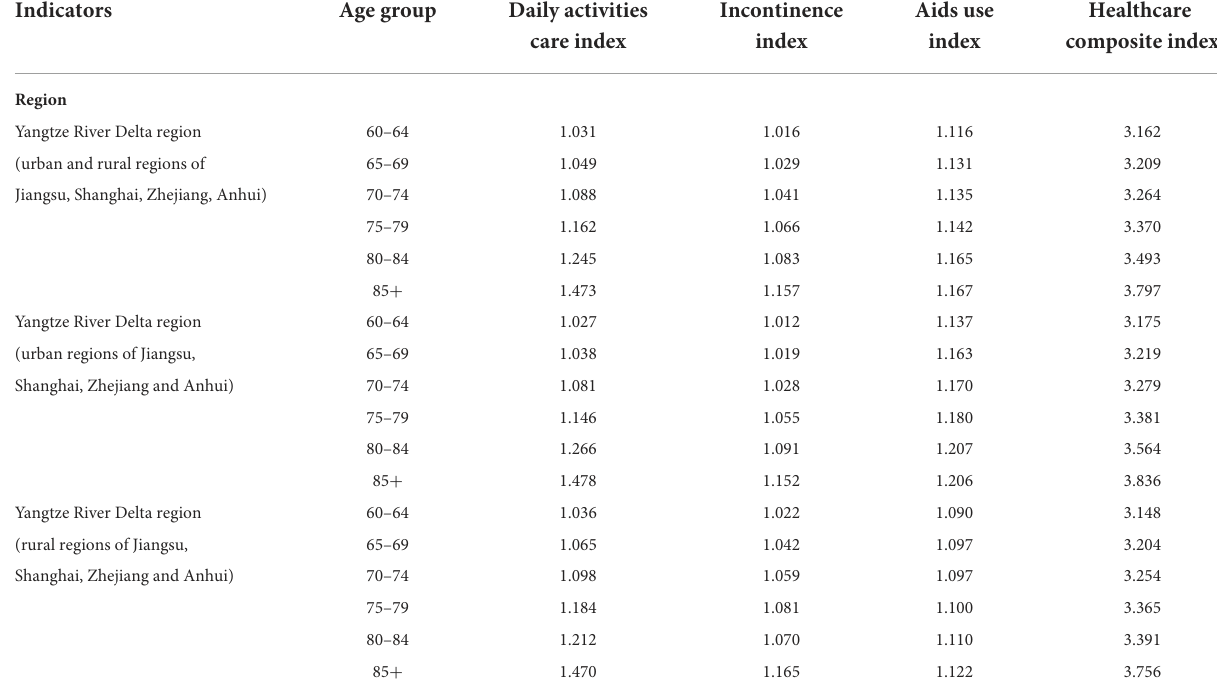
TABLE 2 Elderly healthcare index measurements in the Yangtze River Delta region.